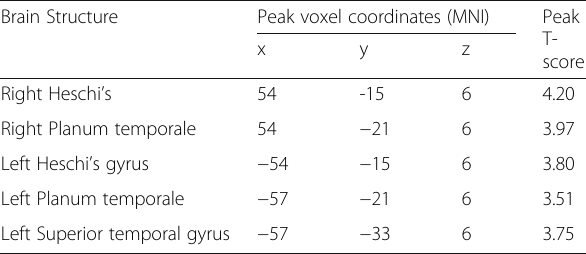
Table 4 Increased functional connectivity in MA compared